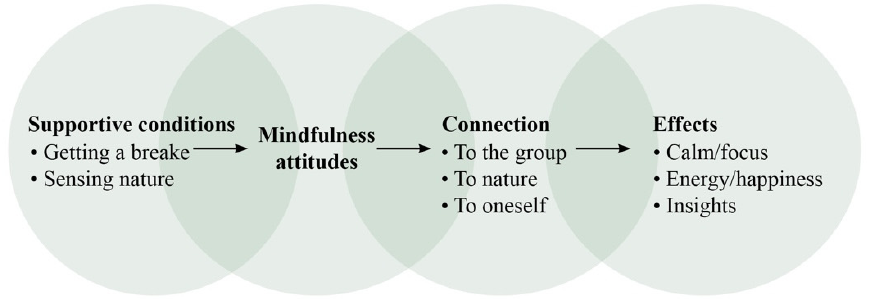
Figure 3. All themes were experienced to various extent during most of the retreat and perceived as supportive for self-regulation. The figure though depicts the general progression during the